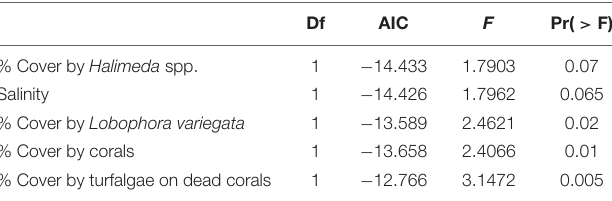
TABLE 5 | Results of the RDA analysis to assess the impact of environmental variables on the genetic population structure of G. caribaeus during the high-resolution sampling period at USVI. Df AIC F Pr( > F) % Cover by Halimeda